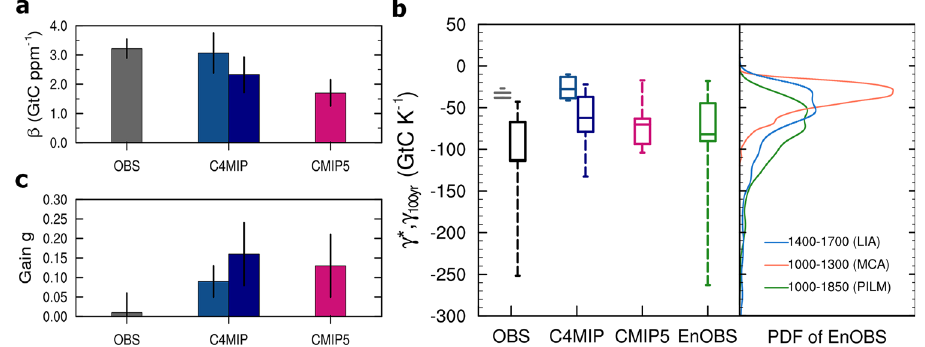
Fig. 3 Ensemble estimates of climate – carbon cycle feedback parameters from observations and models. a Histogram of the β estimates (error bars for mean ± 1 σ ) derived from four instrumental temperature and CO 2 datasets for 1880 – 2017 (in gray), β BGC derived from 11 C 4 MIP models 7 for 1880 – 2017 (in dodger blue) and for 2018 – 2100 (in navy blue), and β BGC derived from nine CMIP5 models 11 for the 140-year 1pctCO 2 experiment (in deep pink). b Boxplot of the γ * derived from four instrumental temperature and CO 2 for 1880 – 2017 (in gray), and γ 100 yr estimates derived from an ensemble of 15 members (3 ice-core CO 2 records × 5 reconstructed temperature, in black) and from the EnOBS for 1000 – 1850 (in green), and γ COU-BGC derived from 11 C 4 MIP models for 1880 – 2017 (in dodger blue) and for 2018 – 2100 (in navy blue), and γ COU-BGC derived from nine CMIP5 models (in deep pink). In b , the large ensemble estimates of the γ 100 yr from the EnOBS also provides probability distributions (right panel) of the cooler period of Little Ice Age (LIA, 1400 – 1700) and the warmer period of Medieval Climate Anomaly (MCA, 1000 – 1300), compared to those of the full preindustrial last millennium (PILM, 1000 – 1850). c Same as ( a ), but for the feedback gain factor ( g ) derived from the β and AF